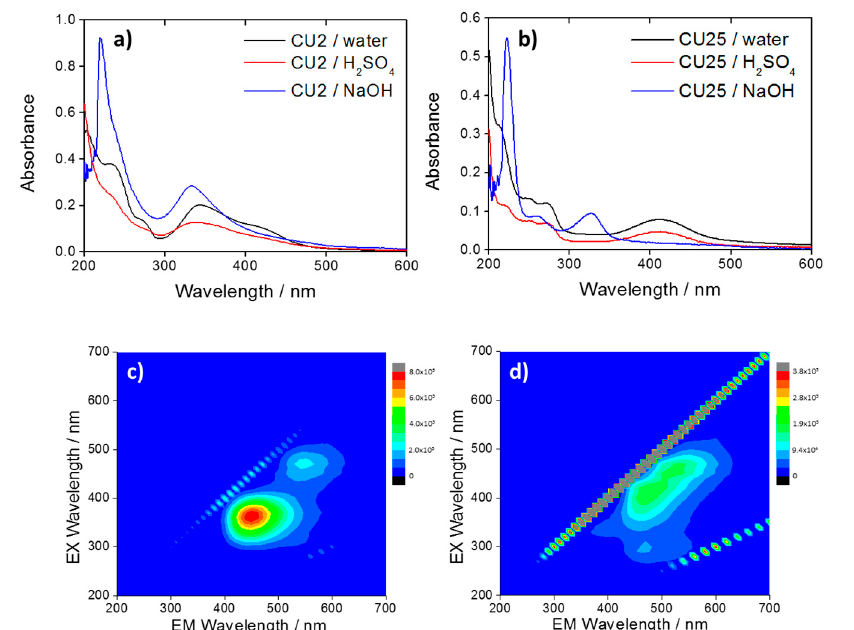
Figure 5. UV–Vis spectra of ( a ) CU2 and ( b ) CU25 in water (black) and in H 2 SO 4 pH 1 (red) and NaOH pH 14 (blue). 3D photoluminescence spectra (excitation (y-axis), emission (x-axis), intensity (false colors scale) of (c ) CU2 C-dots and ( d ) CU25 C-dots in NaOH. C-dots concentration = 10 mg L − 1 .